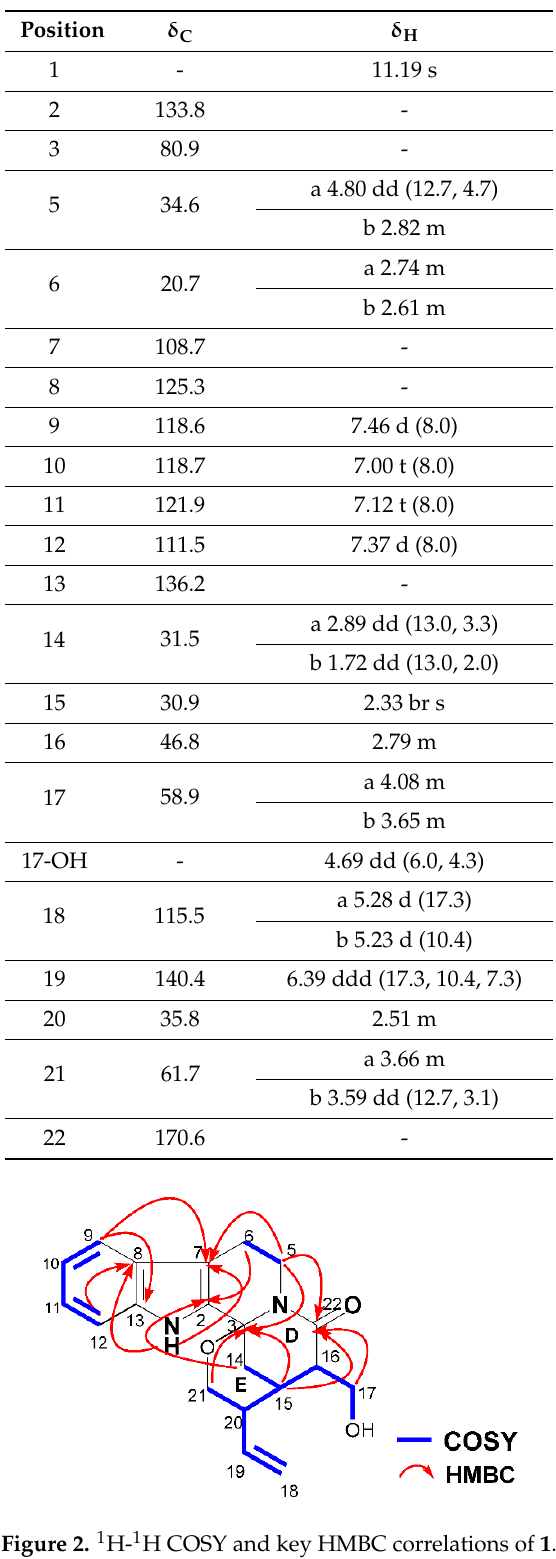
Table 1. 1 H (400 MHz) and 13 C (100 MHz) NMR data of 1 (dimethylsulfoxide- d 6 (DMSO- d 6 ), δ in ppm, J in Hz).